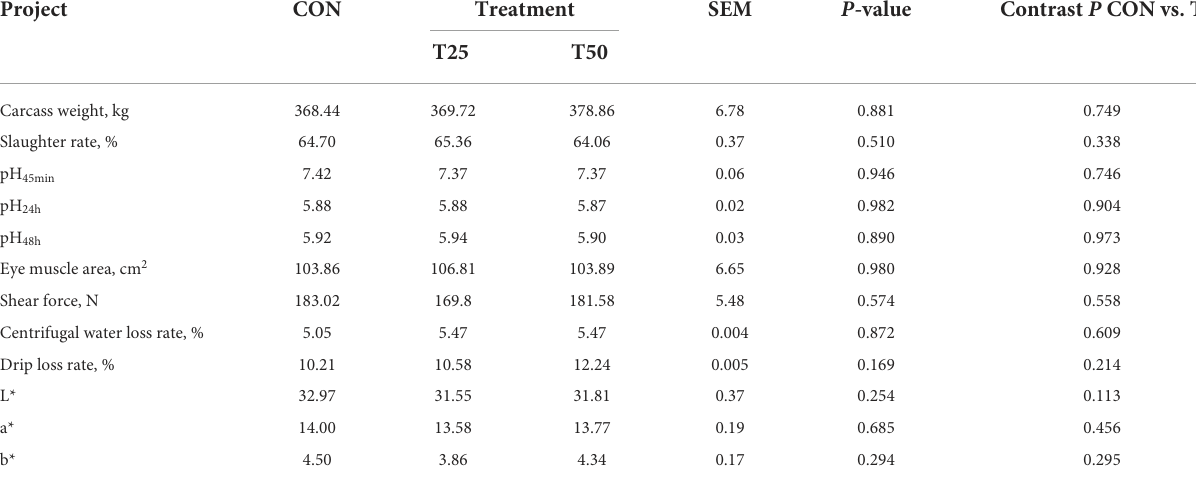
TABLE 5 Effects of different proportions of FPR on slaughter performance and meat